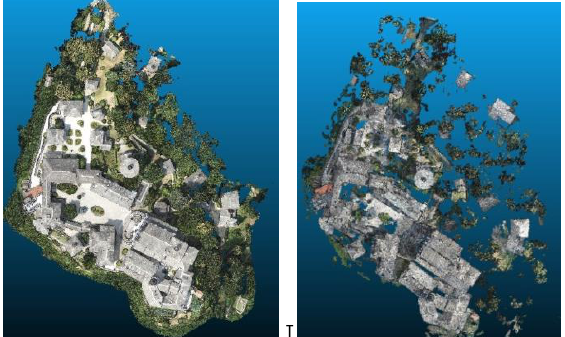
Figure 13. Point clouds with PhotoScan (I) and VisualSFM. (II)